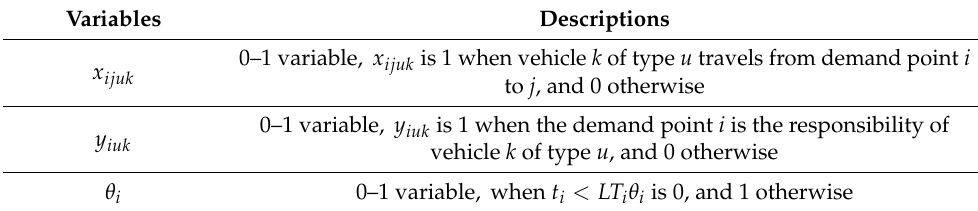
Table 3. Variables’ symbols and